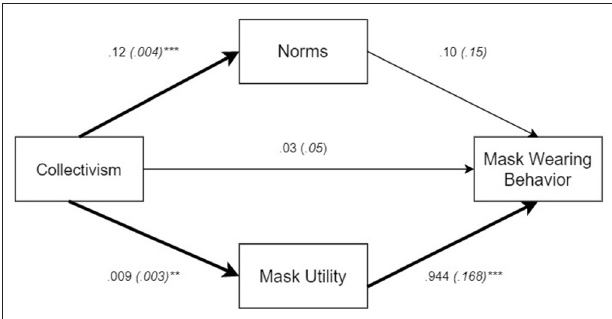
FIGURE 2 | Mediation model pertaining to past mask wearing at the state-level. ** p < 0.01; *** p < 0.001.